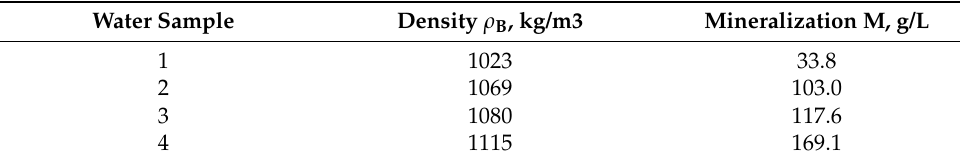
Table 2. Physical and chemical properties of associated waters.